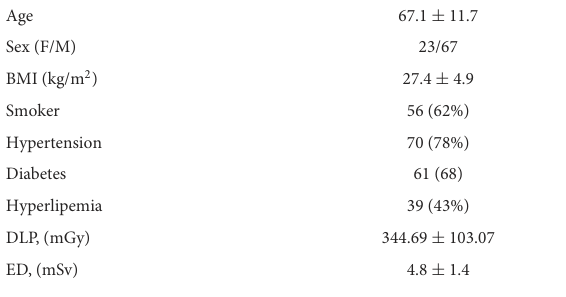
TABLE 2 Patients’ information and radiation dose. TABLE 3 Comparison of sharpness of image between the routine and SE